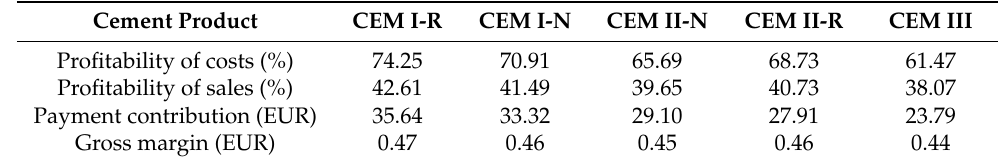
Table 7. Assortment analysis for product—cement. Source: own